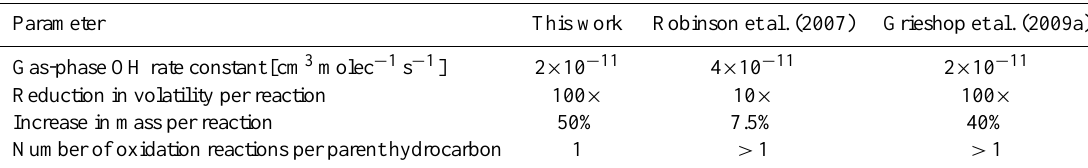
Table 3. Parameters for SVOC oxidation.